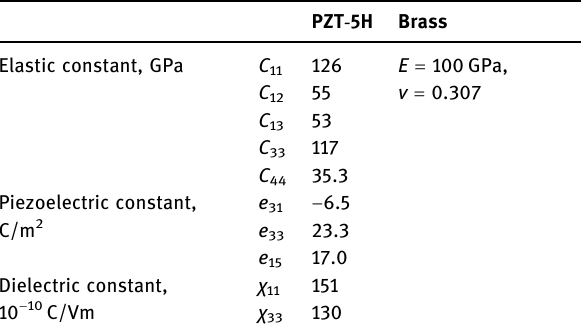
Table 1: Material